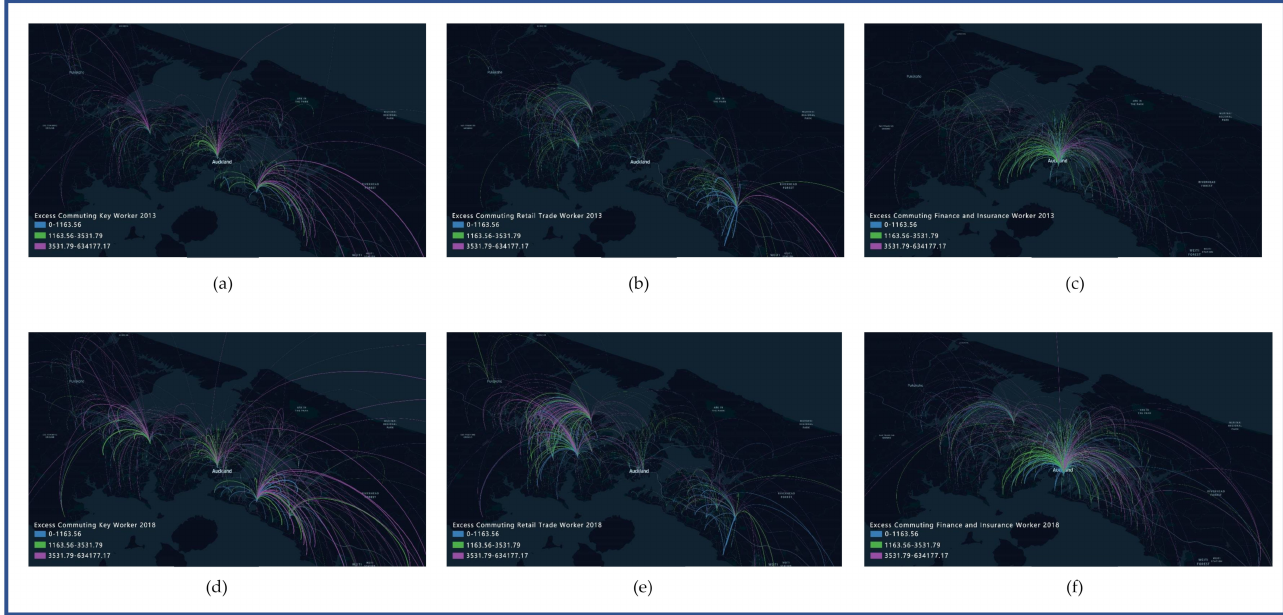
Figure 4. ( a – f ). Excess commuting patterns in 2013 and 2018. Figure ( a – c ) and Figure ( d – f ) illustrated the excess commuting for key workers, retail trade workers and finance and insurance workers in 2013 and 2018, respectively. Notes: The flow diagram is also available online, retrieved from http://cdn-imgjpg.test.upcdn.net/2021/06/17/1ORojfm3.png (accessed on 29 April 2021). To maintain privacy, confidentiality, and data security, Stats NZ will suppress the information from IDI (remove its value) when it releases its data outputs. Thus, we can only use the commuting data of the meshblocks with more than six workers living in a meshblock. The detailed microdata output guide can be retrieved from https://www. stats.govt.nz/assets/Uploads/Integrated-data-infrastructure/microdata-output-guide-fourth-edition.pdf (accessed on 29 April